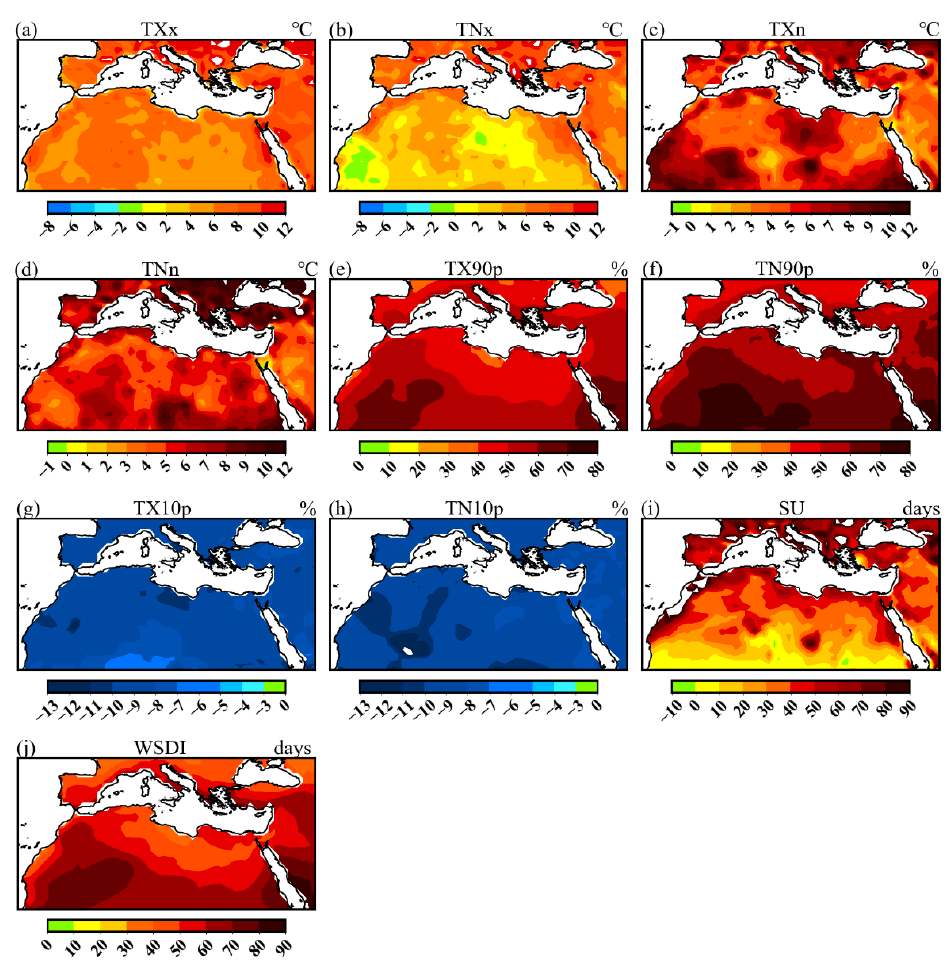
projected towards the end of the century over MED at 3 ◦ C to 9 ◦ C, and 4 ◦ C to 6 ◦ C over SAH (Figures 9d and 10d).